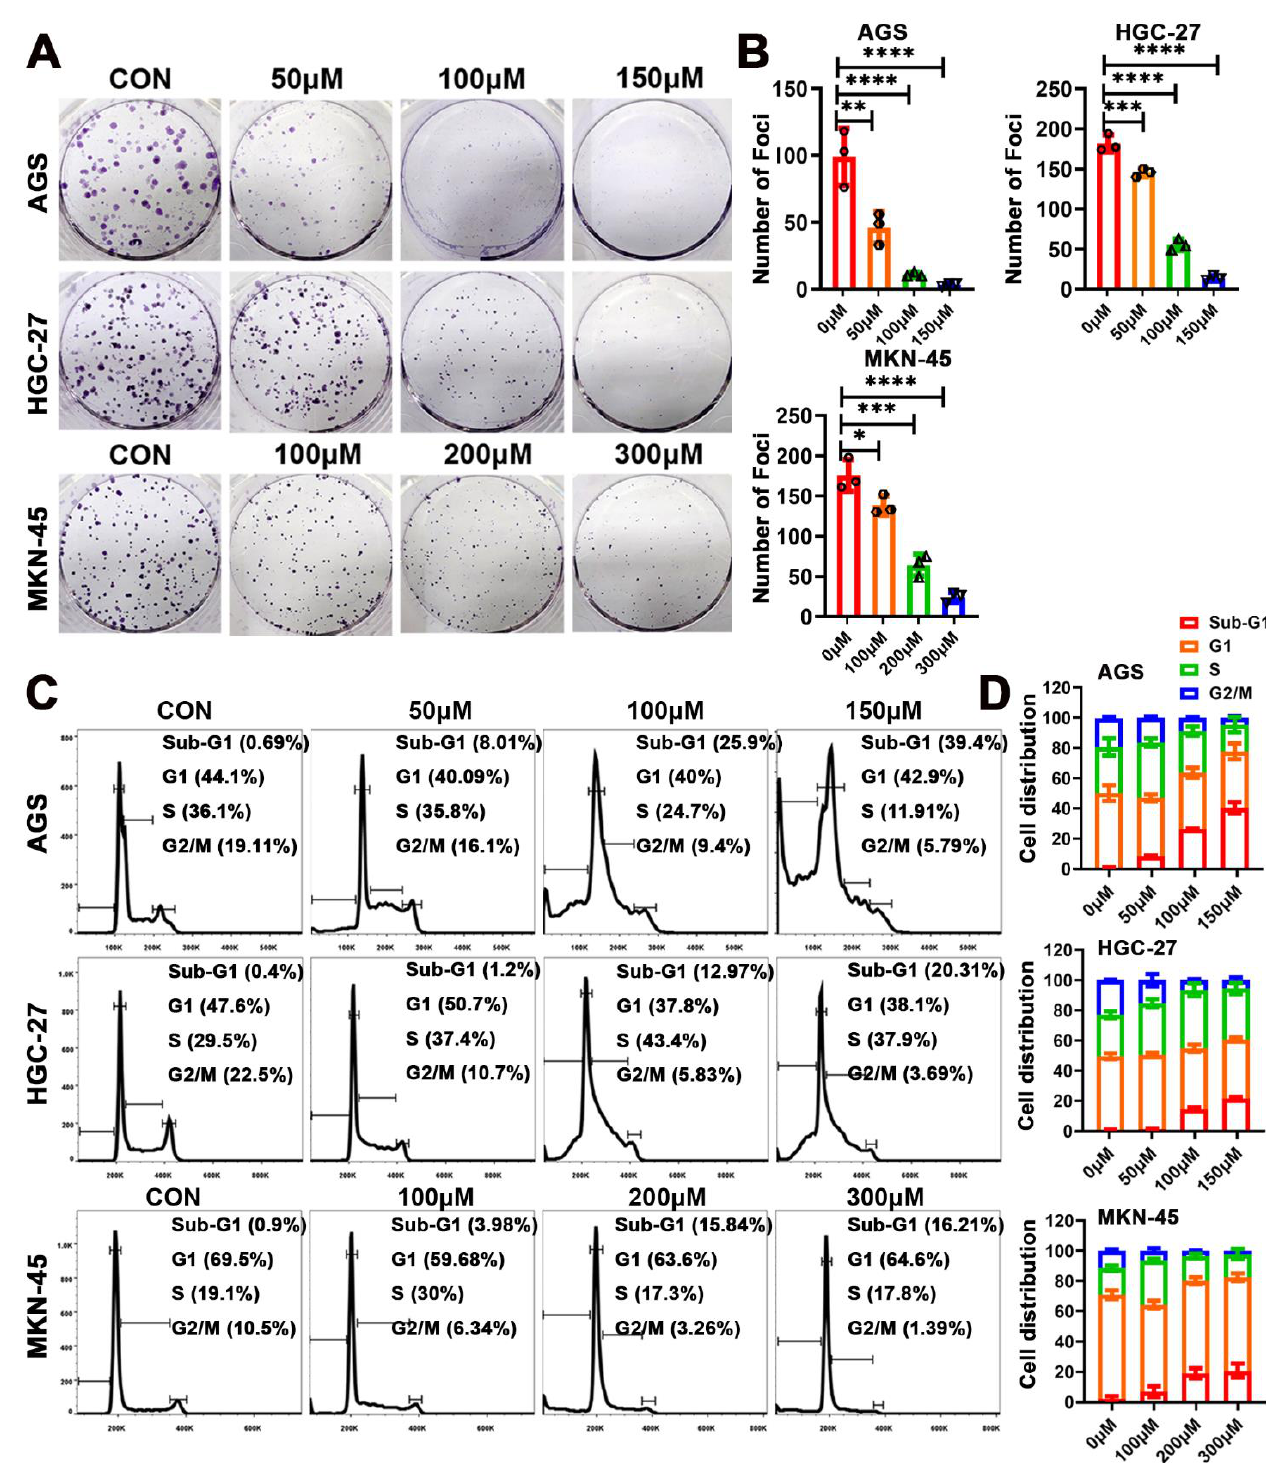
Figure 2. Eriodictyol inhibits cell proliferation of GC cells. ( A ) The representative graphs of colony formation assays are shown. ( B ) The quantitative analysis of colony formation assays is demonstrated as a histogram. ( C ) The cell cycle distribution was analyzed using flow cytometry, and the representative results are shown. ( D ) The quantitative analysis of cell cycle distribution is demonstrated as a histogram. Three independent experiments were performed, and data are presented as mean ± SD. * p < 0.05, ** p < 0.01, *** p < 0.001, **** p < 0.0001.